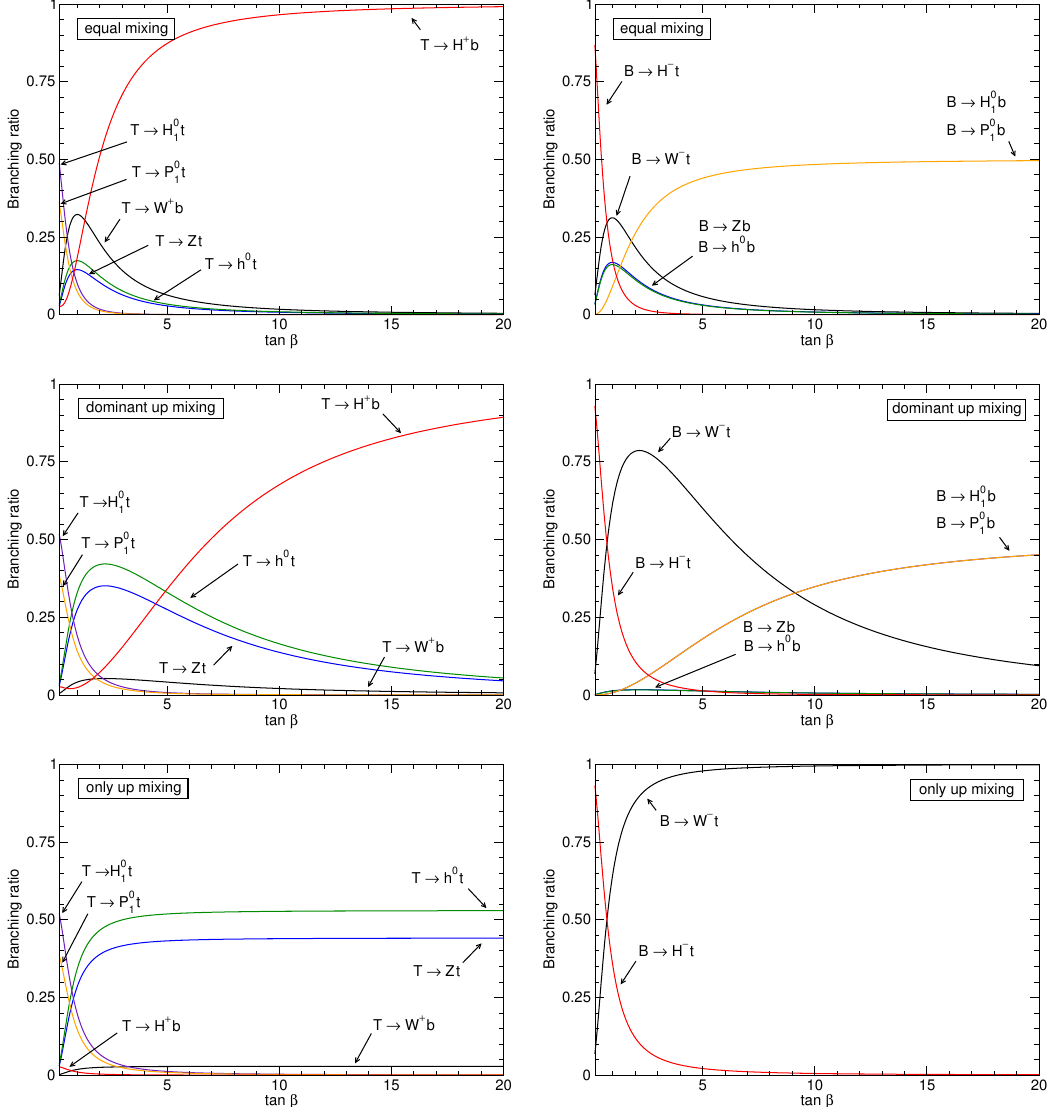
Figure 1 . Dependence of the T and B branching ratios on tan (cid:12) , for the equal mixing and dominant up mixing scenarios of tables 1 and